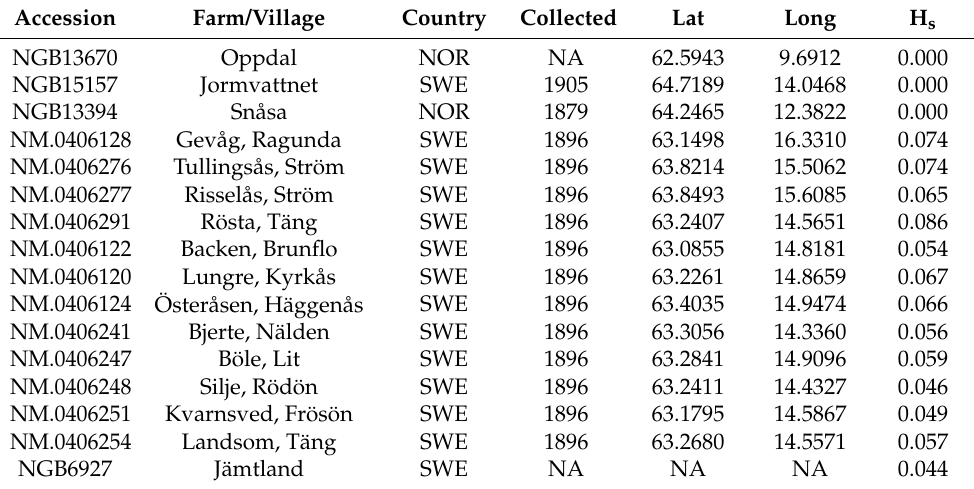
Table 1. Original collection site, country, collection year, coordinates, and within-accession genetic diversity (H s ) of the studied